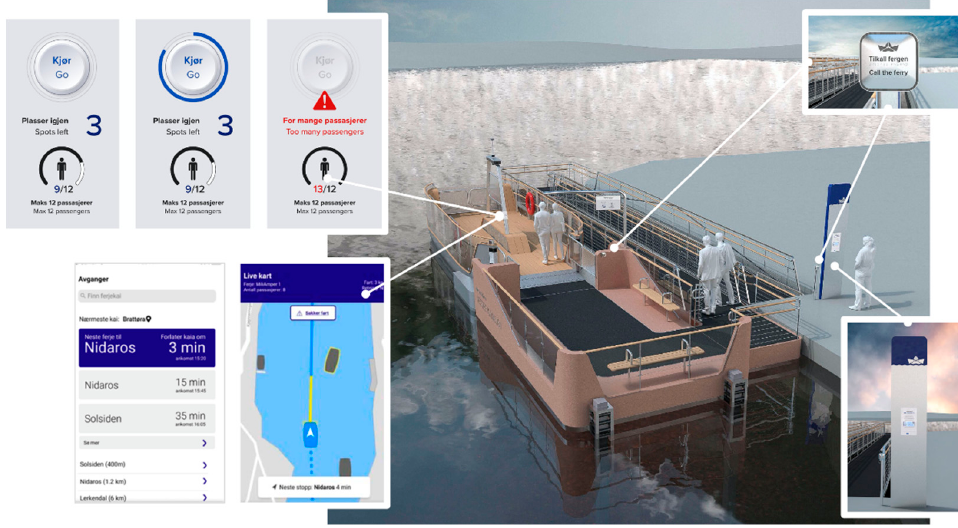
Figure 6. Establishing an interaction relationship with passengers of milliAmpere2.